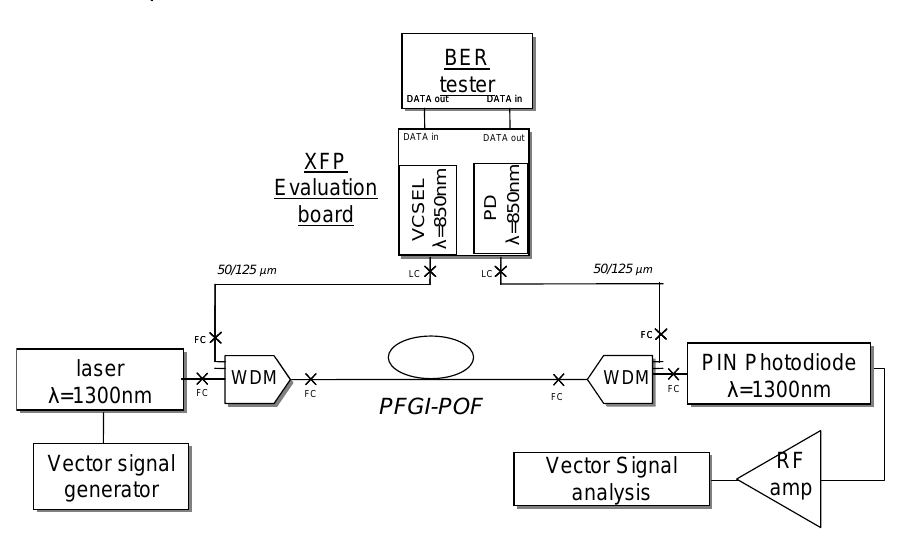
Figure 20. Overview of the test setup used to evaluate the performance of the multi-services concept on